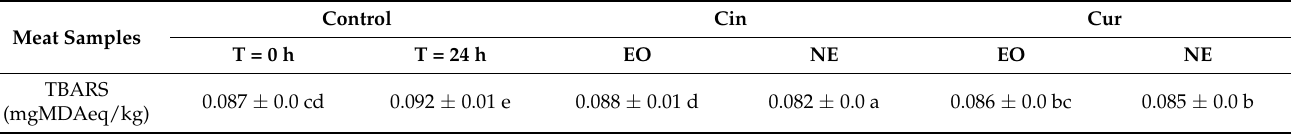
Table 6. TBARS (expressed as mgMDAeq/kg) assays of the control (t = 0 and t = 24 h) and of the minced meat treated with cinnamon EO, cinnamon NE, curcuma EO, and curcuma NE for 24 h. Meat